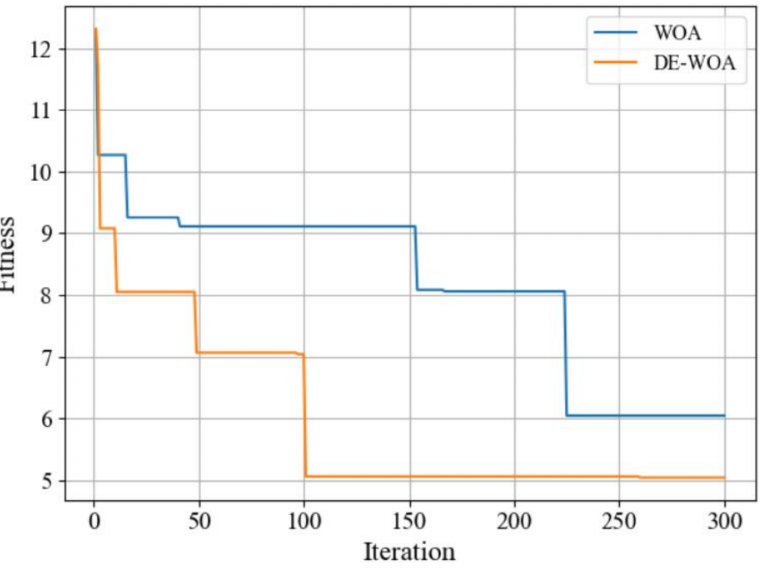
Figure 6. Convergence diagram of total amount of demand that is not